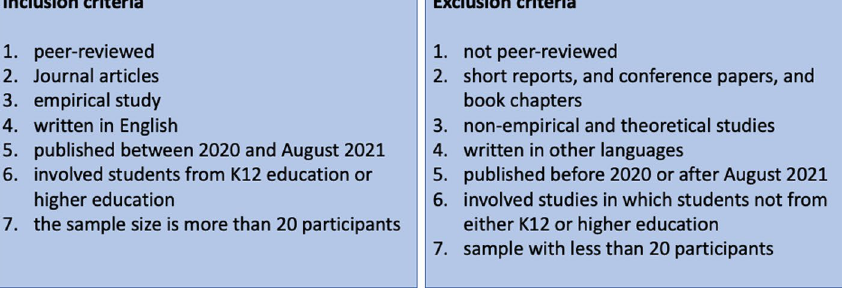
Fig. 1 Inclusion and exclusion